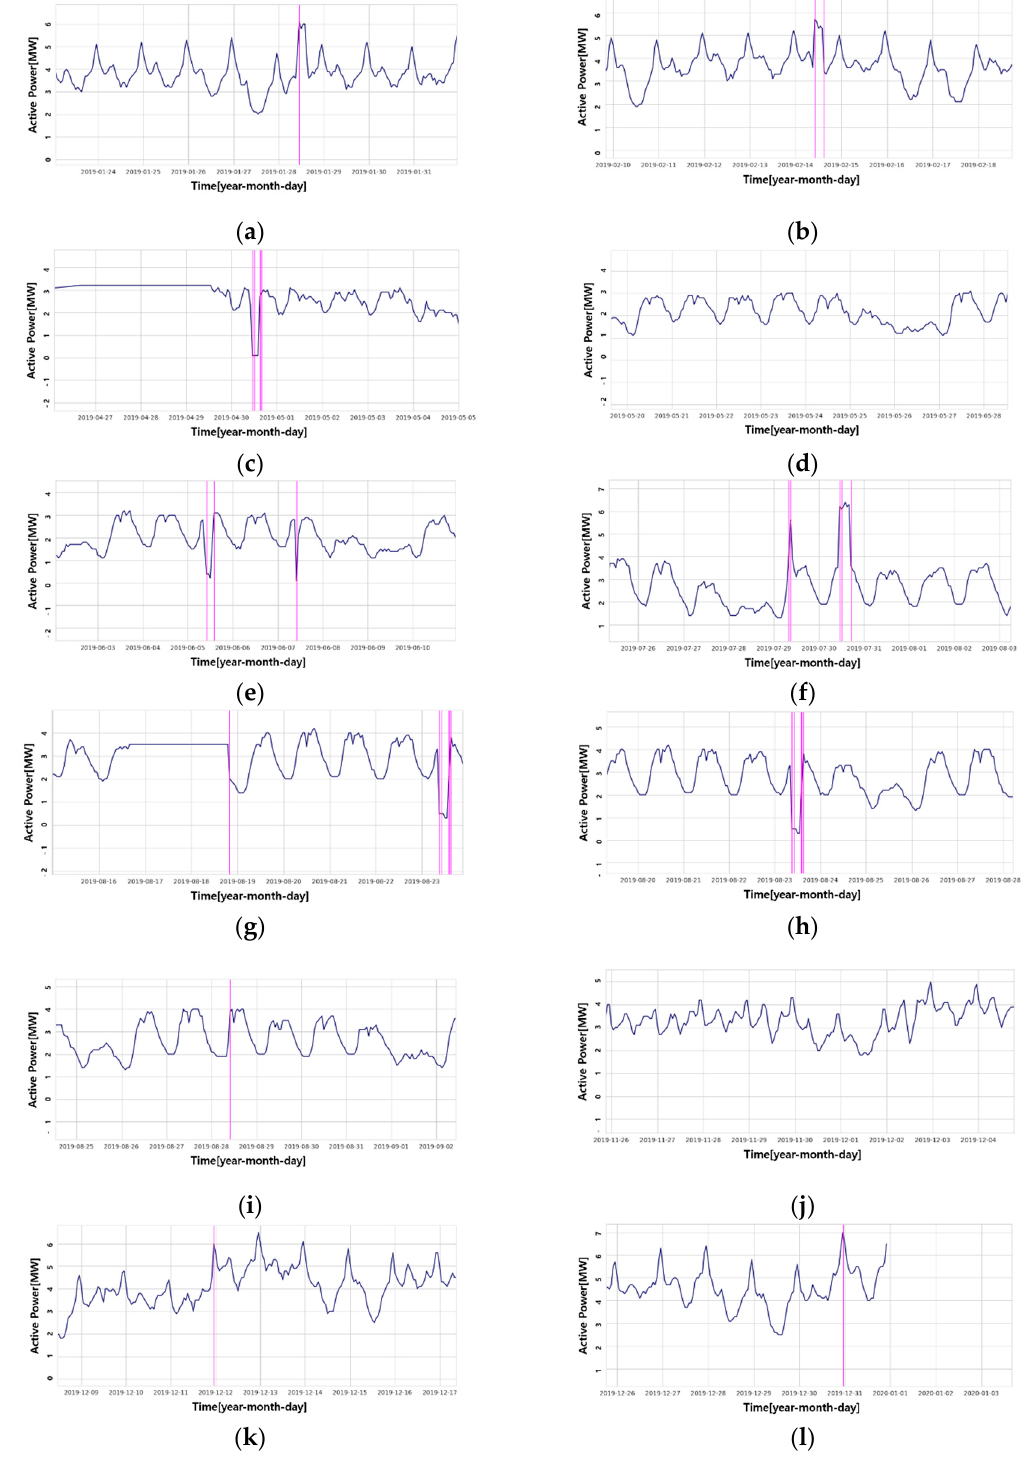
Figure 6. The results of detection for load transfer using proposed method: ( a ) 2019.01.28 ( b ) 2019.02.14. ( c ) 2019.04.30. ( d ) 2019.05.24. ( e ) 2019.06.06–07. ( f ) 2019.07.29–30. ( g ) 2019.08.18. ( h ) 2019.08.23. ( i ) 2019.08.28. ( j ) 2019.11.29. ( k ) 2019.12.11. ( l )